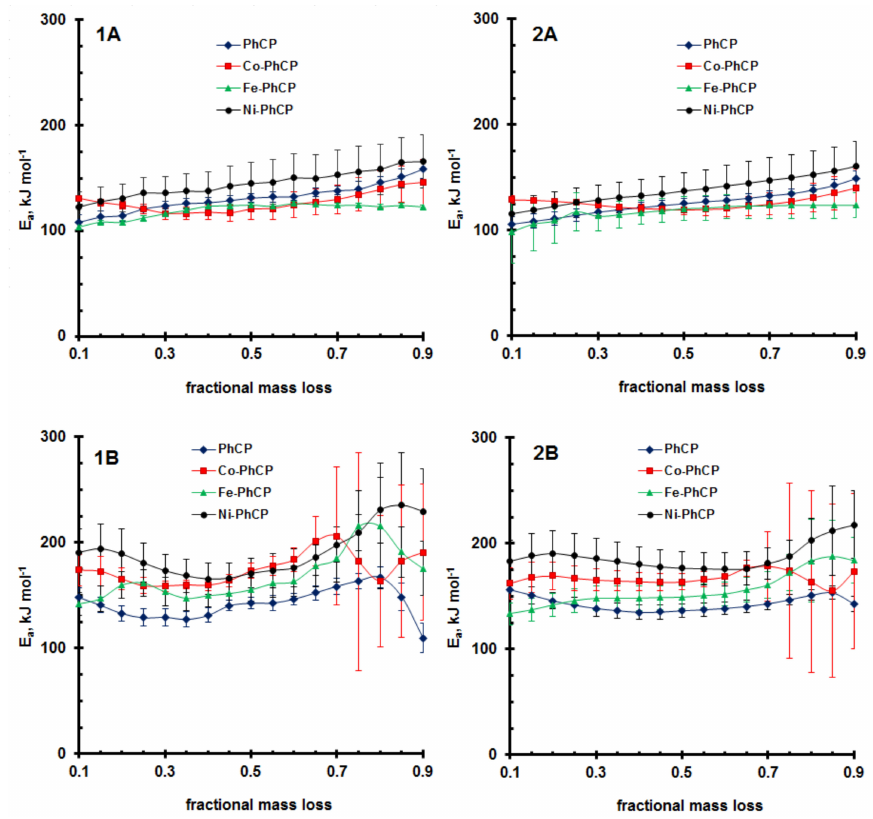
Figure 3. Variations of E a vs. fractional mass loss ( α ) for the second ( A ) and third ( B ) degradation stages of the samples based on Friedman ( 1 ) and OFW ( 2 )